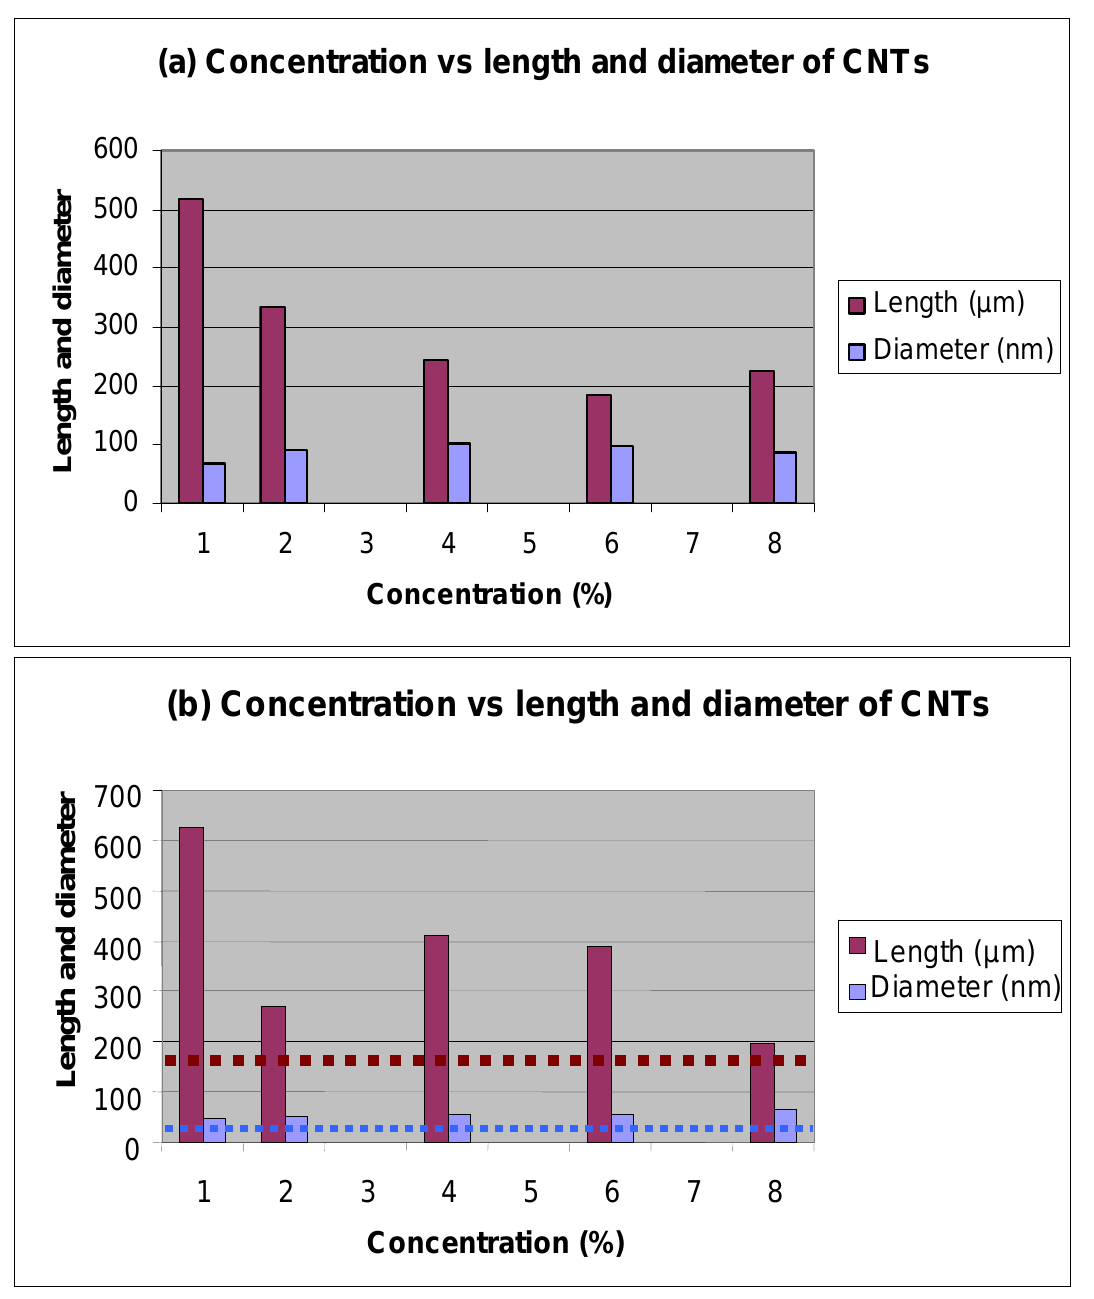
FcH/benzylamine; and (b) FcH/hexamethylenediamine mixtures. Horizontal dotted line indicates lengths and diameters of CNTs obtained from FcH/toluene. (Letsoala, P.J.; Cele, L.M.; Nxumalo E.N.; Coville, N.J. The influence of nitrogen sources on nitrogen doped multi-walled carbon nanotubes. Unpublished work.)